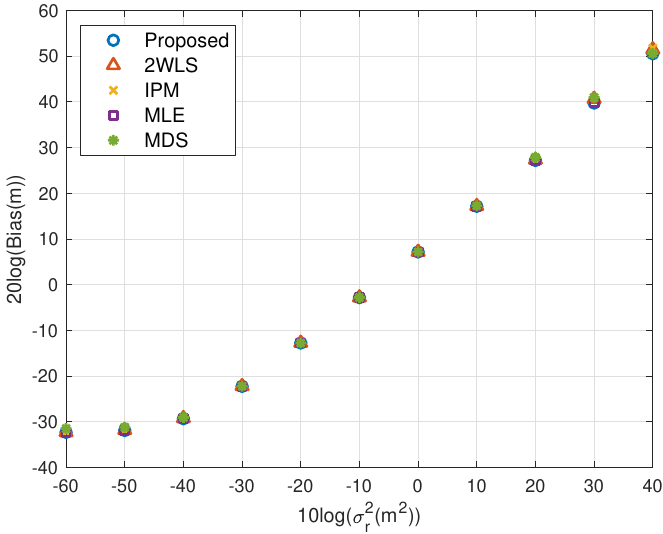
Figure 11. Bias performance as noise power increasing (near source, 6